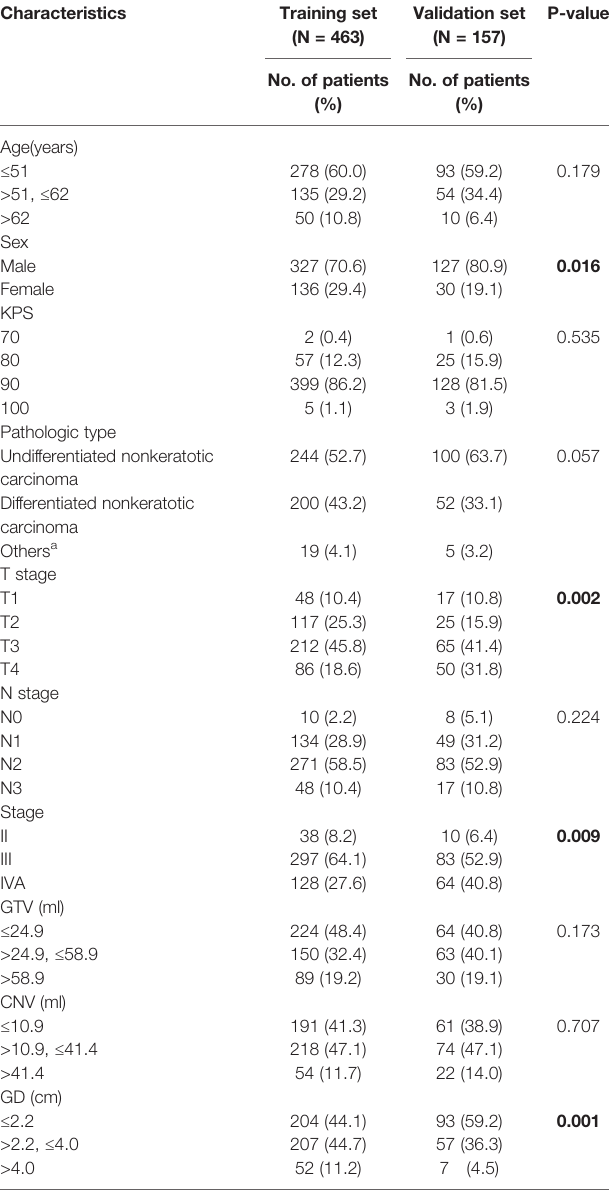
TABLE 1 | Clinical features of patients with nasopharyngeal carcinoma.